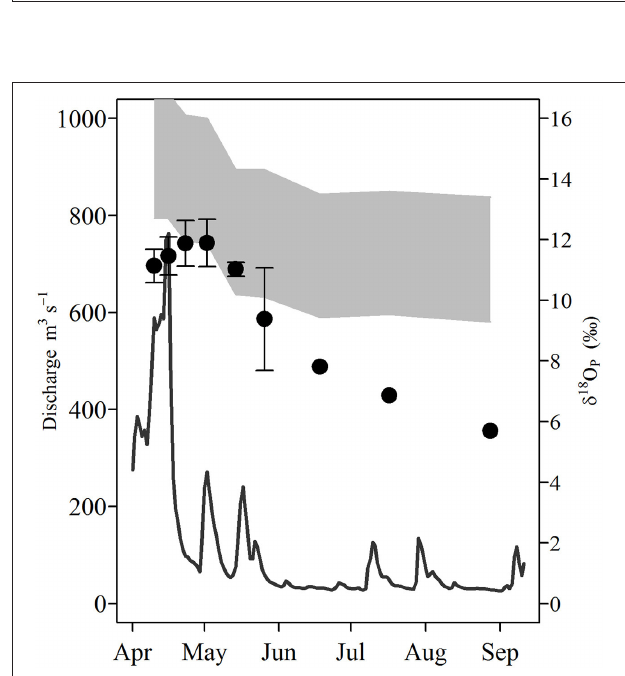
FIGURE 5 | Temporal variation of Grand River discharge (m − 3 s − 1 ; solid line) and δ 18 O P measured at the river mouth during the study period (circles, error bars represent 1 SD of multiple measurements). Shaded gray area